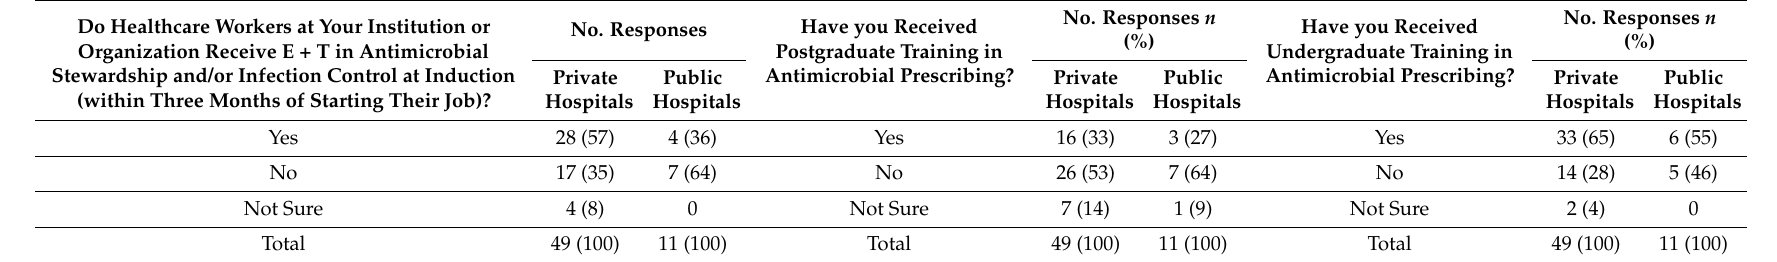
Table 1. Employer provided education and training (E&T) at induction and throughout